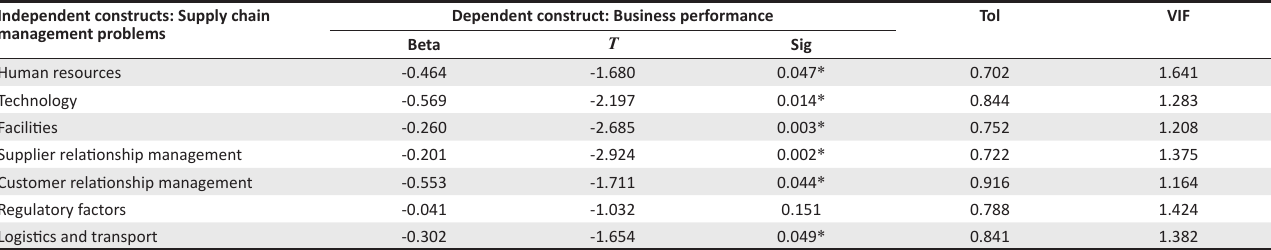
TABLE 3: Regression model: Supply chain management problems and business performance.